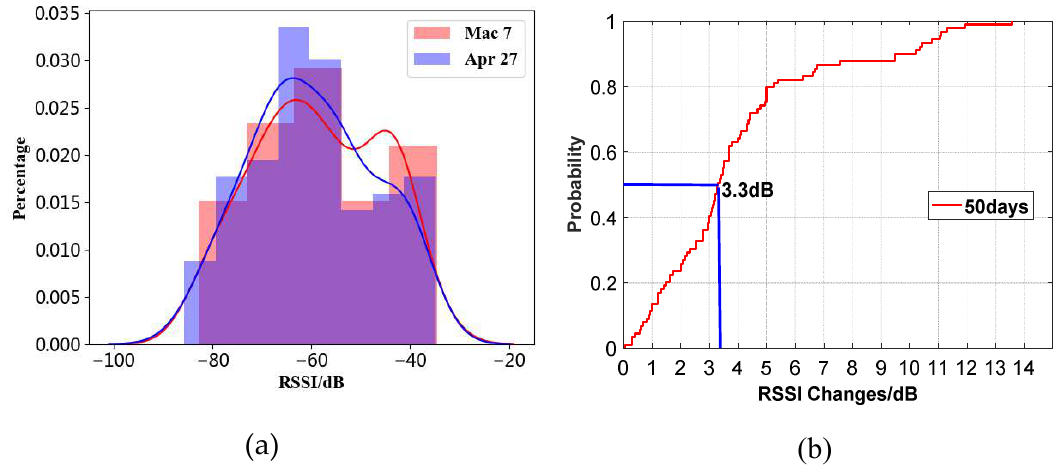
Figure 3. The dynamic fluctuation of Wi-Fi signal with time in an o ffi ce building. ( a ) RSSI data distribution of di ff erent Wi-Fi signals at di ff erent times in a specific location. ( b ) RSSI changes of di ff erent Wi-Fi signals over a 50-day period in a specific